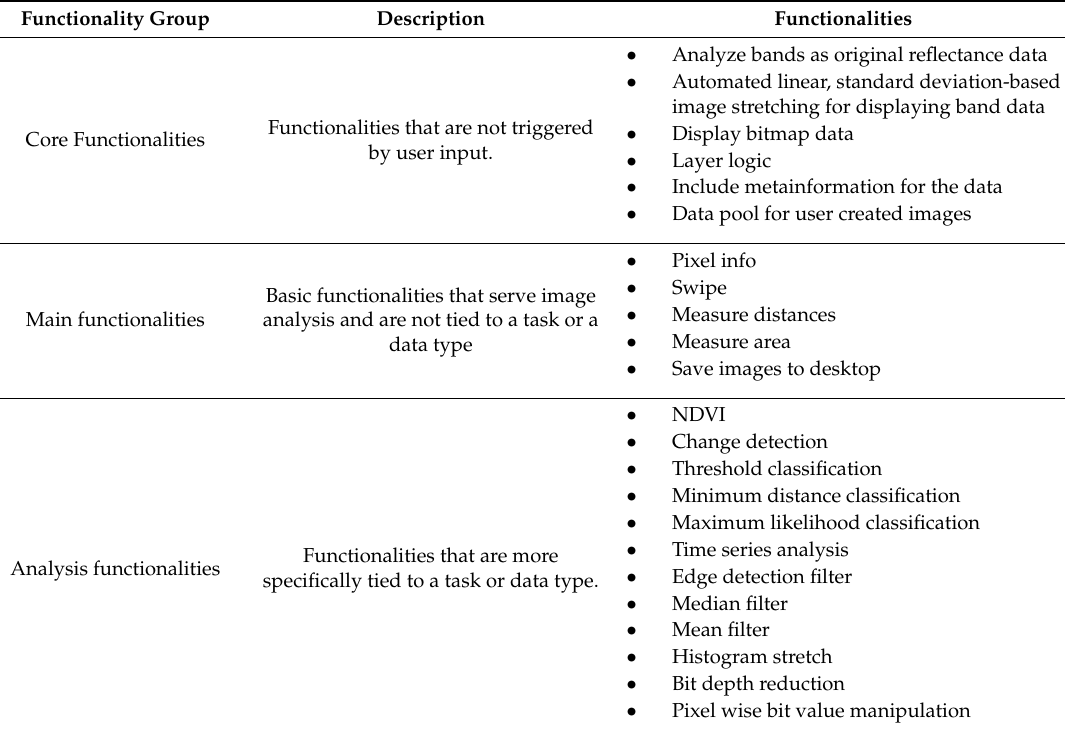
Table 2. Functionalities implemented in the learning